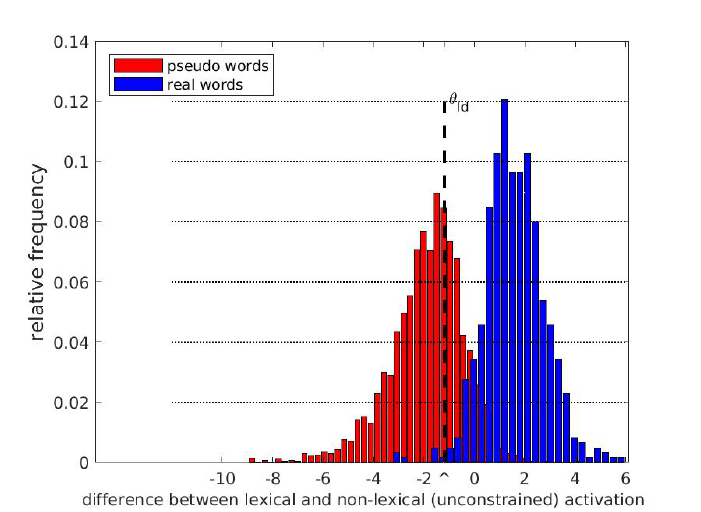
Figure A1. Histogram of the difference of lexical activation and non-lexical activation of 2780 existing words (blue) and 2761 pseudo-words (red) in BALDEY. The dashed vertical line indicates the lexical decision threshold (denoted θ with subscript ld, lexical decision); its optimal value depends on the task. In the figure, it is chosen such that the probability of words erroneously receiving a pseudo-word label would be